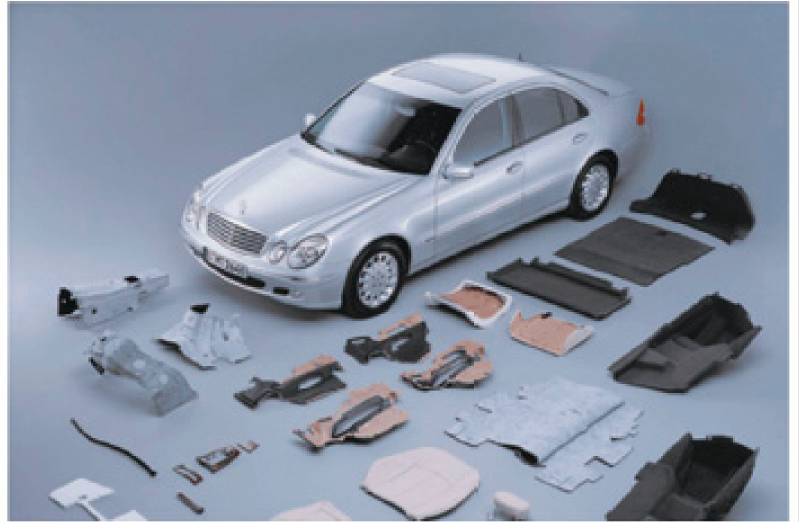
Figure 4. Automobile components fabricated with natural fiber related composites. Reprinted with permission from the publisher [16]. Open